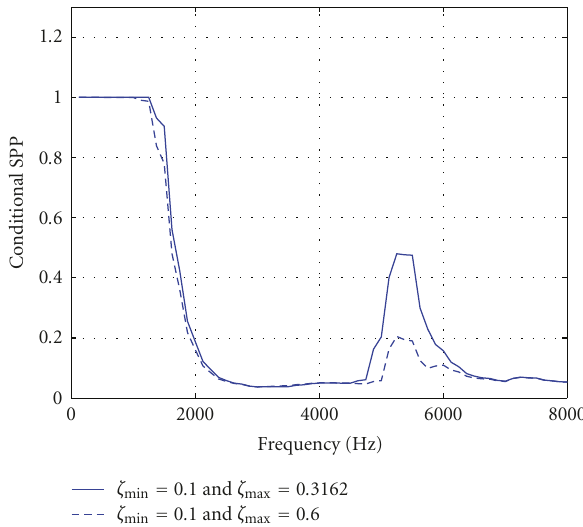
Figure 5: Conditional SPP with high-speech presence at low frequency.